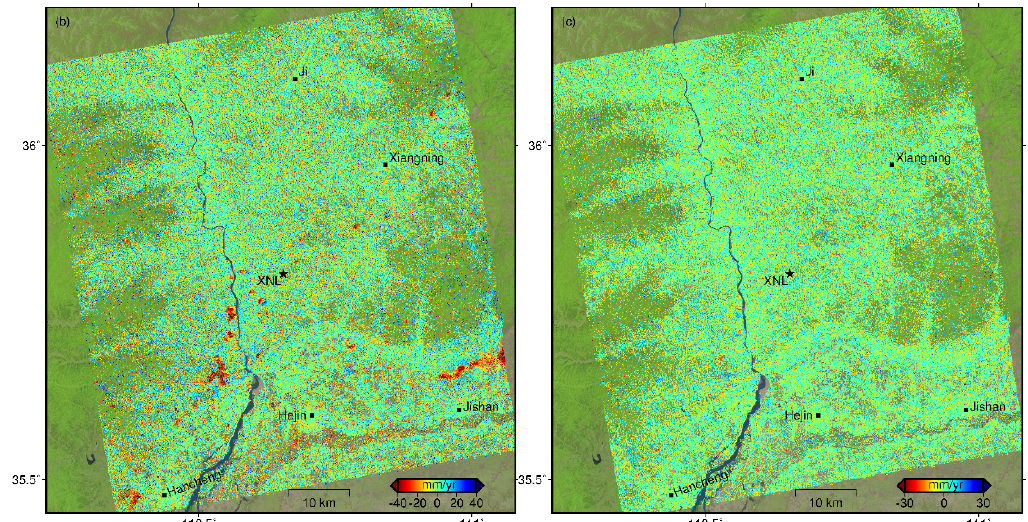
Figure 5. Displacement velocity map derived from Sentinel-1 datasets. ( a ) The total mean line of sight (LOS) displacement velocity, S marks the location of the weather station; ( b ) the linear component and ( c ) the nonlinear component. The background is a Sentinel-2 image covering our study area acquired on 5 June 2018. The black square outlines the mining induced displacement area to be analyzed in Figure 7. P1, P2, and P3 are selected points for the time series analysis in Figure 9.